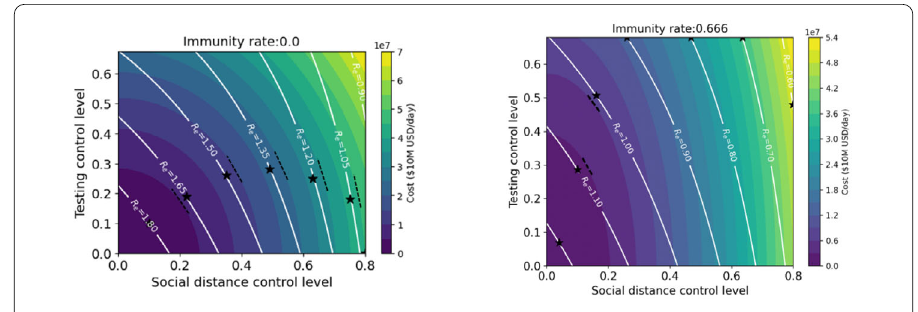
Figure 5 R e and cost dependence on testing and social distancing control levels at two different population immunity levels: Stars locate points on R e contours corresponding to minimum cost for the given value of R e